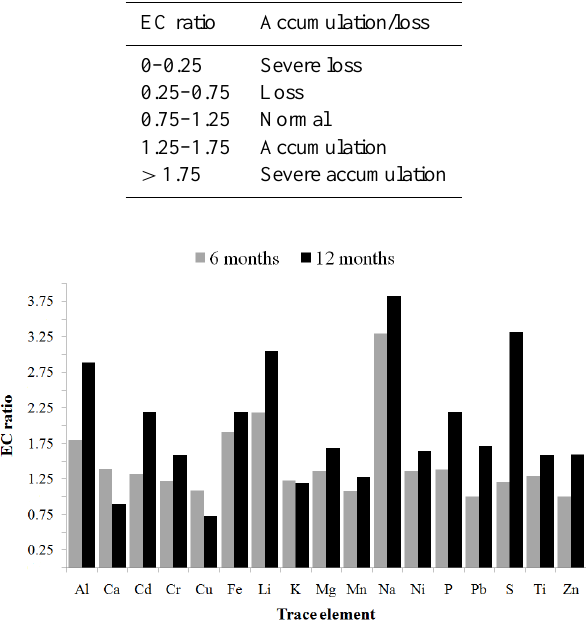
Table 2. Scale for the interpretation of the exposed to control (EC) ratios (Frati et al., 2005).